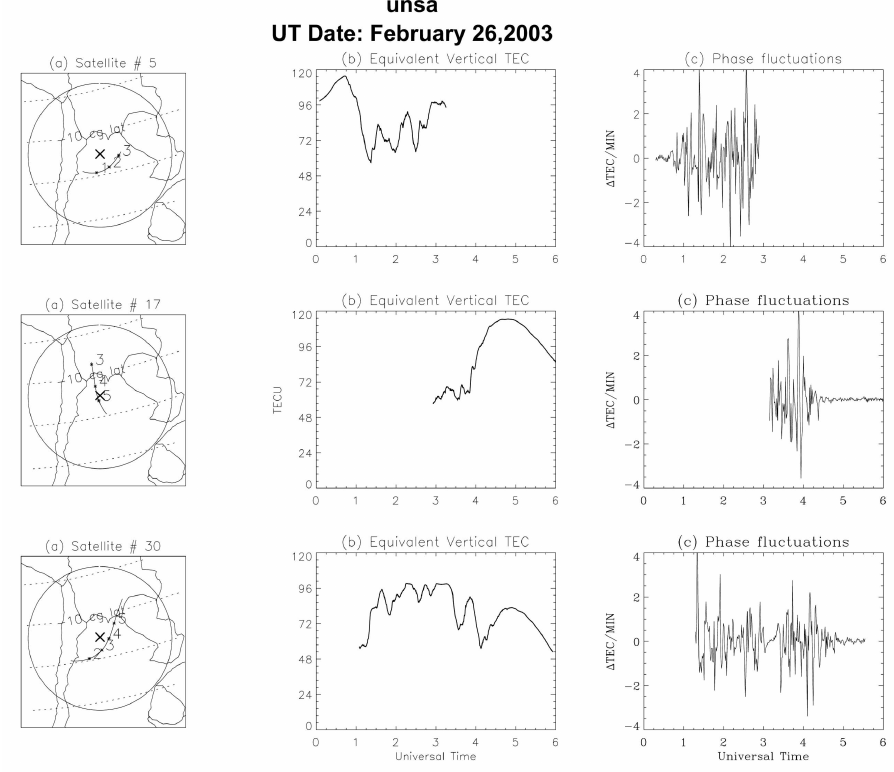
Fig. 4. GPS observations from UNSA (24.73 ◦ S, 65.41 ◦ W) for the night of 26 February 2003, coincident with the imaging data shown in Fig. 3 (bottom panel). (a) the passes of three satellites are shown. The circles are at 350km and 15 ◦ elevation angle; (b) vertical total electron content (TEC), in units of 10 16 el/m 2 , plotted as a function of universal time, showing the presence of TEC depletions; (c) corresponding phase fluctuations (or total electron content rate of change, dTEC/dt). The temporal/spatial coherence of airglow depletions, TEC reductions, and enhanced phase fluctuations are standard signatures of ESF